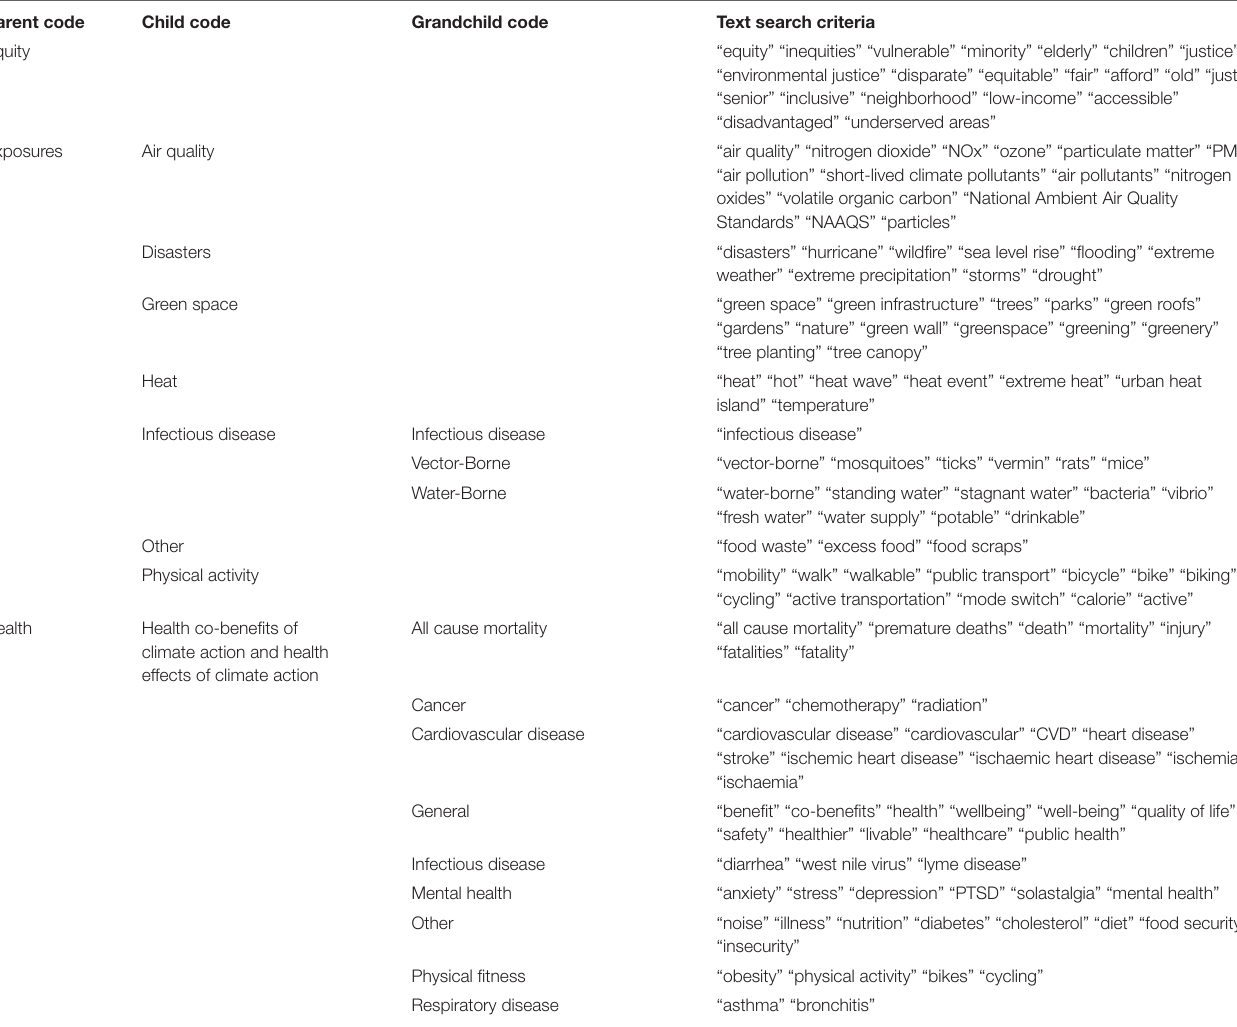
TABLE 1 | Coding structure used as a basis for our qualitative review, including three tiers of codes and associated synonyms for text search criteria. Parent